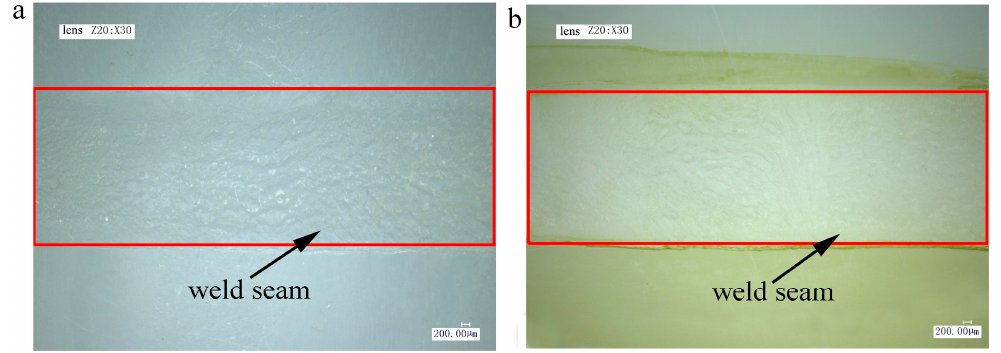
Figure 4. The weld seam of welding samples after shearing test: ( a ) PE; ( b ) POM.